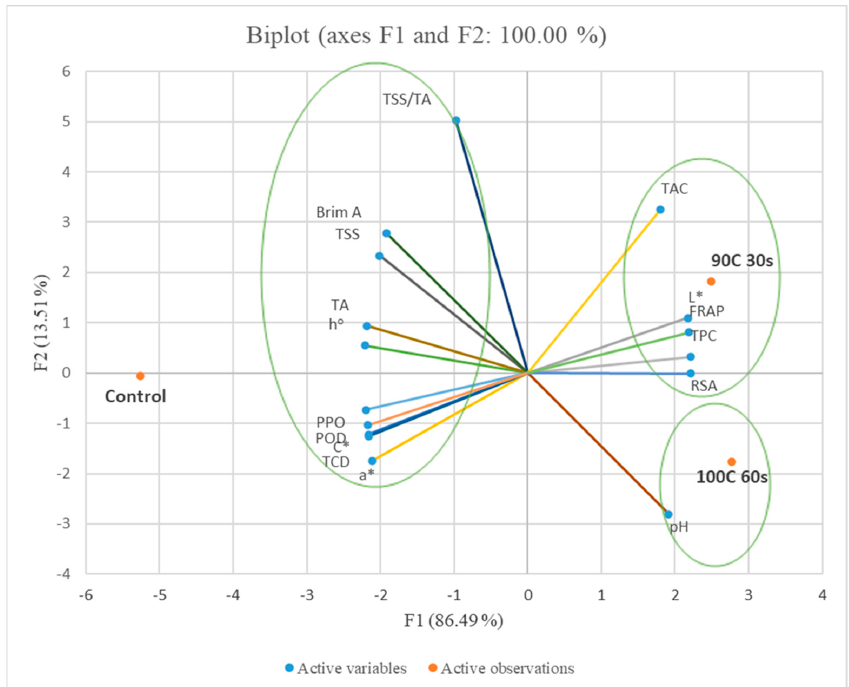
Figure 6. Principal component analysis of the first two factors (F1 and F2) based on physicochemical properties, phenolic content and antioxidant activities of dried pomegranate arils cv. Wonderful at different blanching conditions. L *; lightness, a *; redness , C *; chroma, h °; hue angle, TCD, total colour difference, RSA, radical scavenging activity; FRAP, ferric reducing antioxidant power, TPC, total phenolic content; TAC, total anthocyanin content; PPO, polyphenol oxidase; POD, peroxidase; TSS, total soluble solids; TA, titratable acidity.